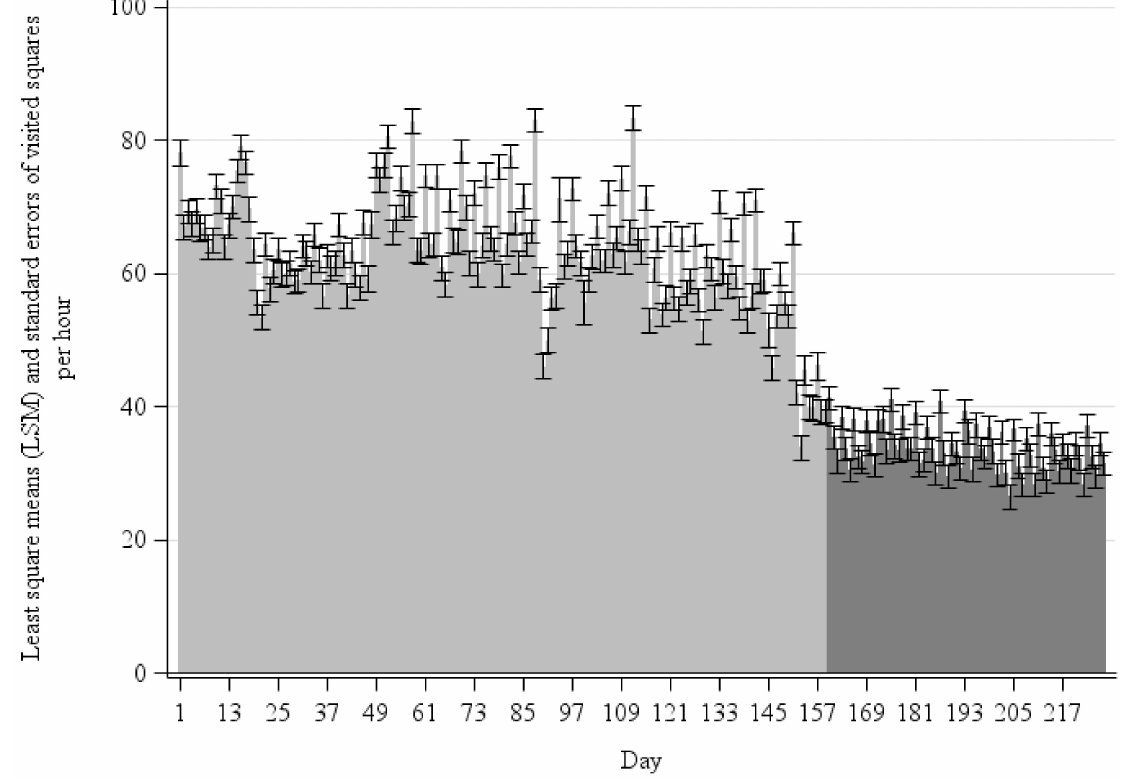
Figure 3. Least square means (LSM) and the standard errors of the squares visited per hour depending on the individual observation day including the pasture (light gray: summer/dark gray: